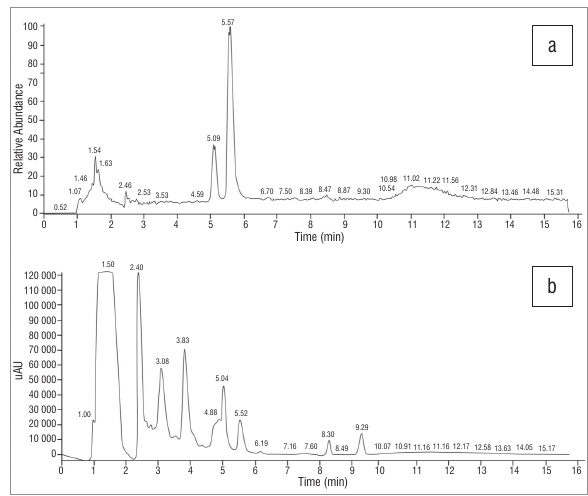
Figure 6 : Chromatograms of Sceletium exalatum derived from (a) electro- spray ionisation mass spectroscopy and (b) high-performance liquid chromatography with UV.